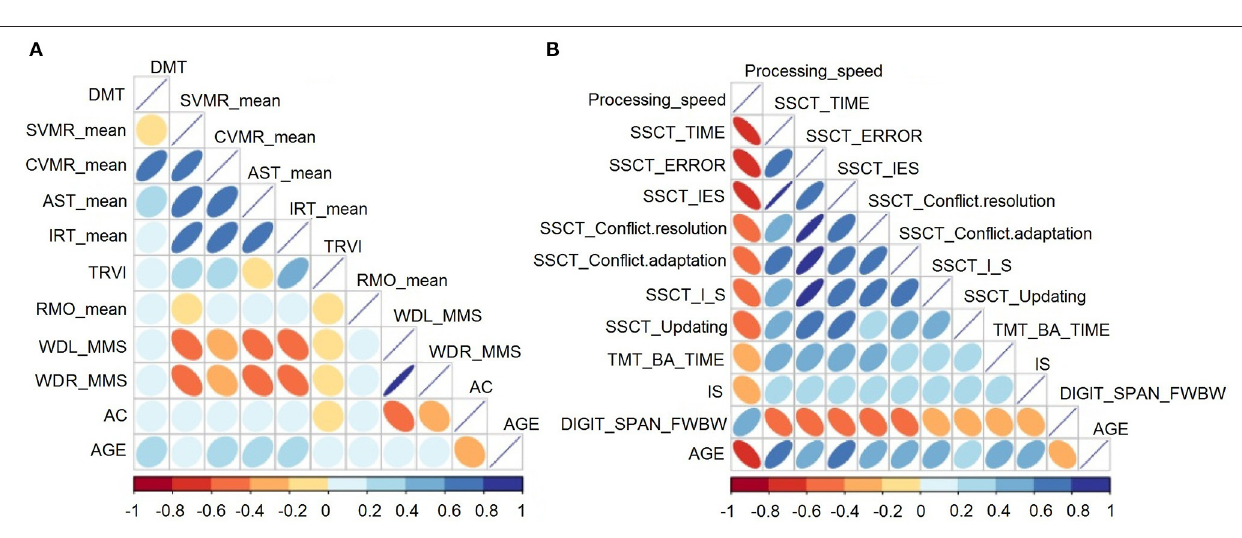
associated with all psychophysiological parameters ( p < 0.05) except for TRVI, RMO_mean, and wrist